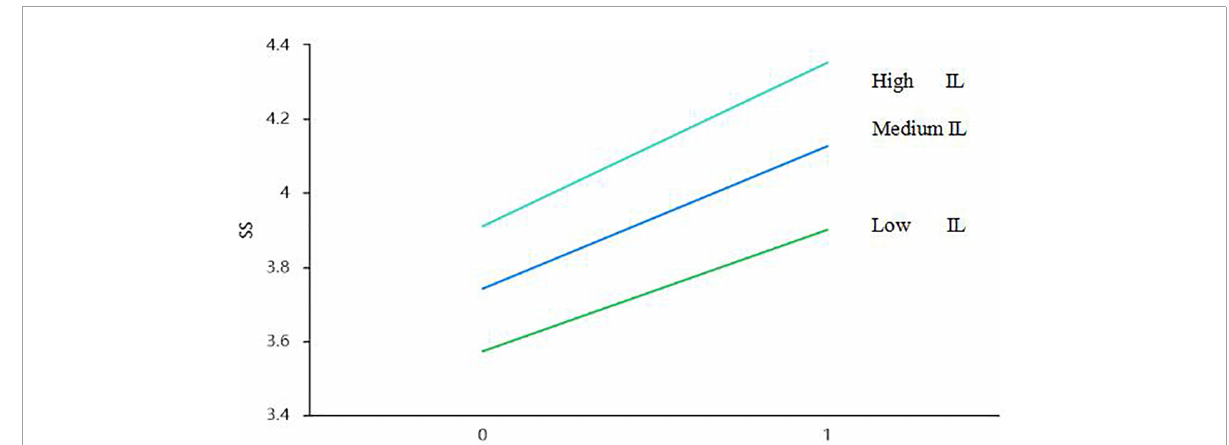
the strength of individuals’ SS under the impact of ML. Thus, H5 was